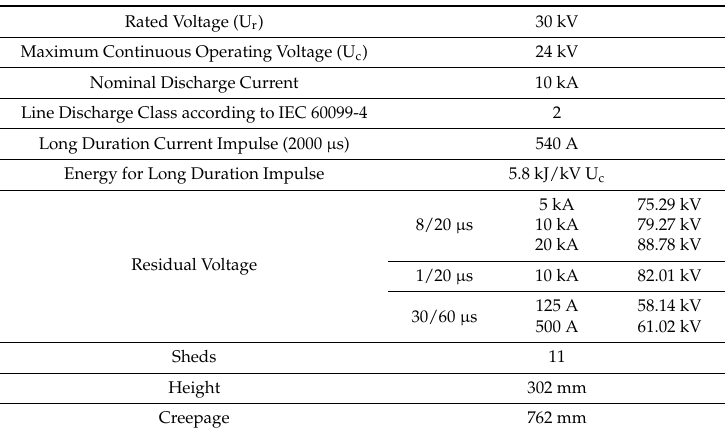
Table 1. Characteristics of the arrester under study.